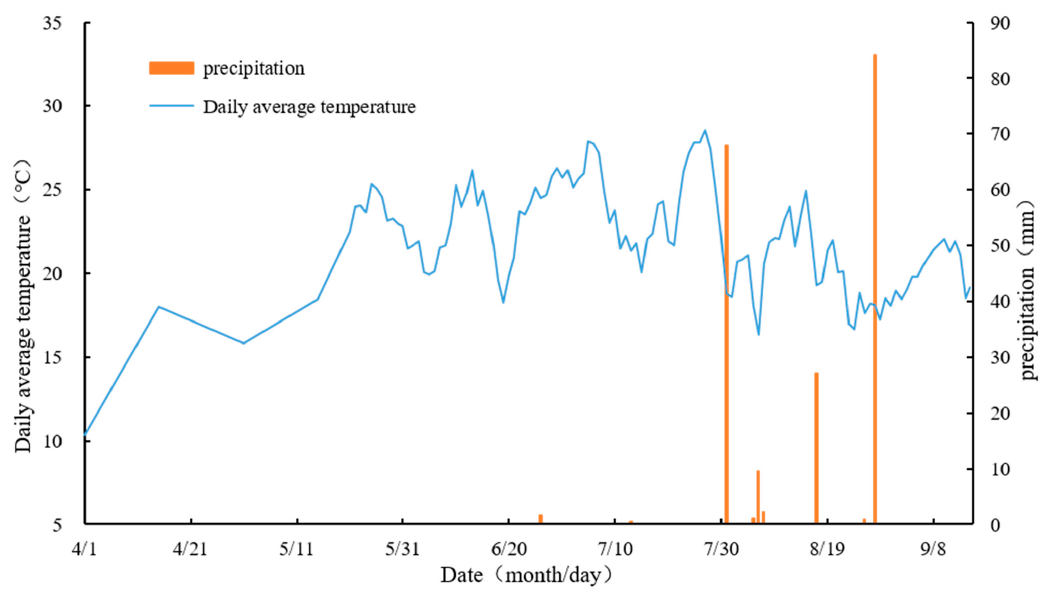
Figure 1. Meteorological data.